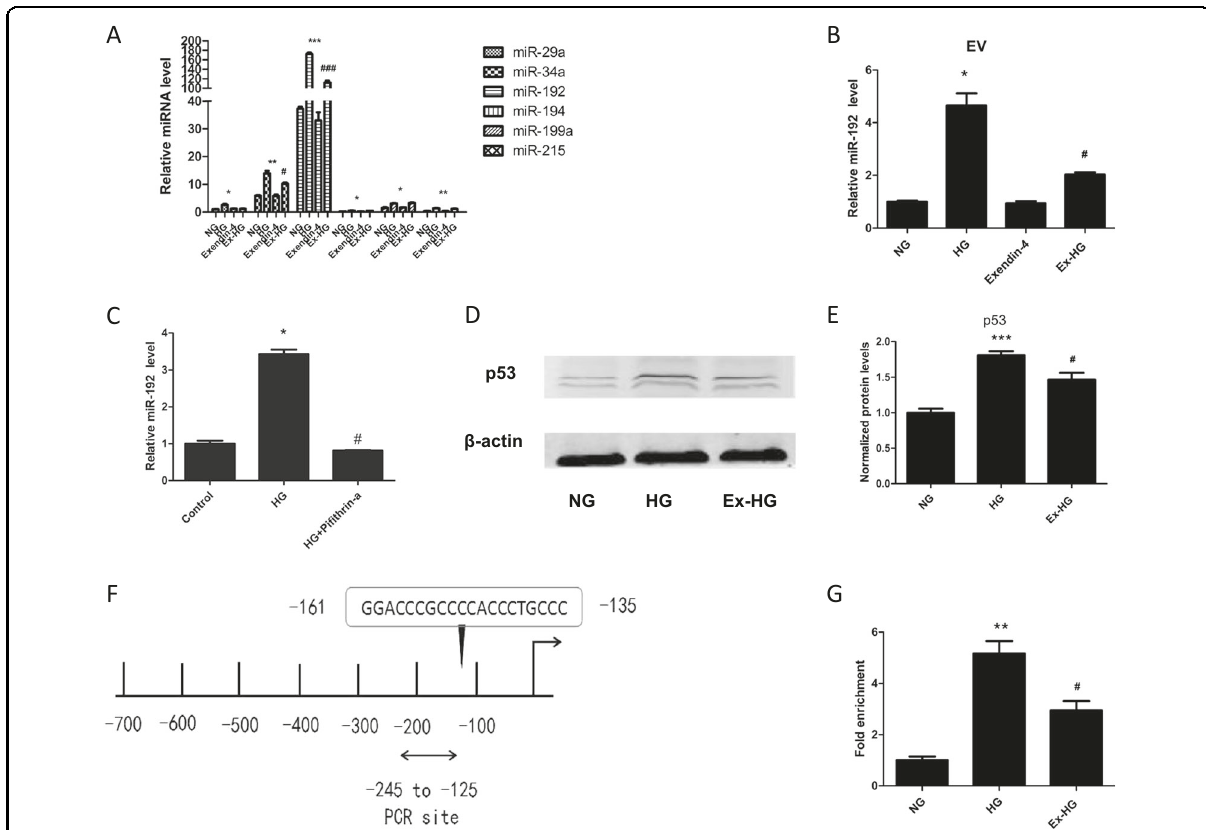
Fig. 4 Exendin-4 inhibited miR-192 expression via p53. a Effect of exendin-4 treatment on the expression of miRNA in HK-2 cells exposed to HG. b Effect of exendin-4 treatment on the expression miR-192 in EVs derived from HK-2 cells exposed to HG. c Effect of pi fi thrin- α treatment on the expression miR-192 in HK-2 cells exposed to HG. d , e Effect of exendin-4 treatment on the expression of p53. f Predicted p53-binding sites on the miR-192 promoter. g Exendin-4 inhibits the binding of p53 to the miR-192 promoter (* P < 0.05, ** P < 0.01, and *** P < 0.001 versus the NG group; # P < 0.05 versus the HG